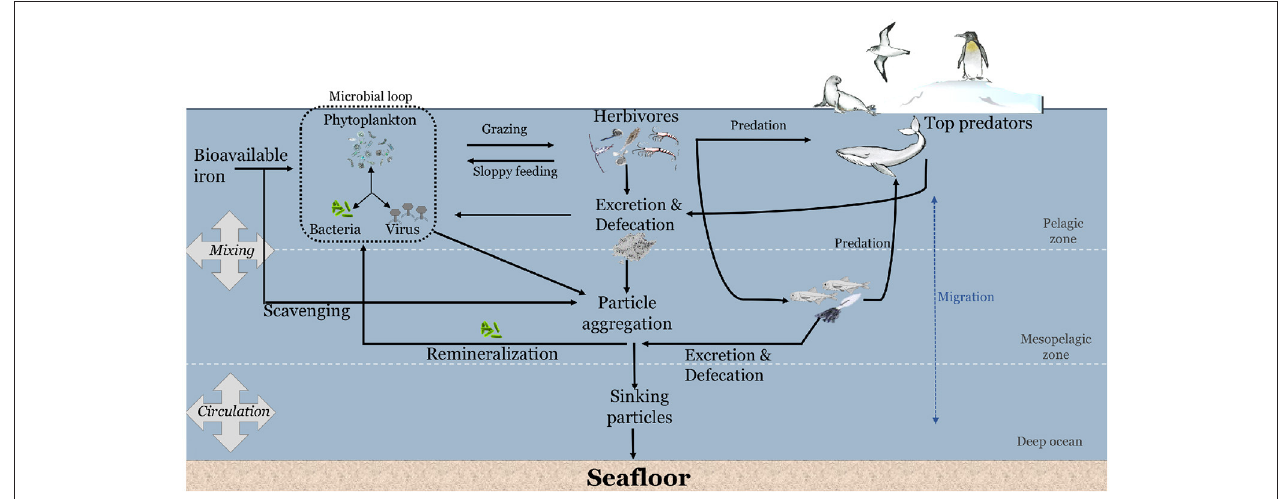
FIGURE 1 | Conceptual diagram on the potential contribution of marine animals to the cycling of iron in the Southern